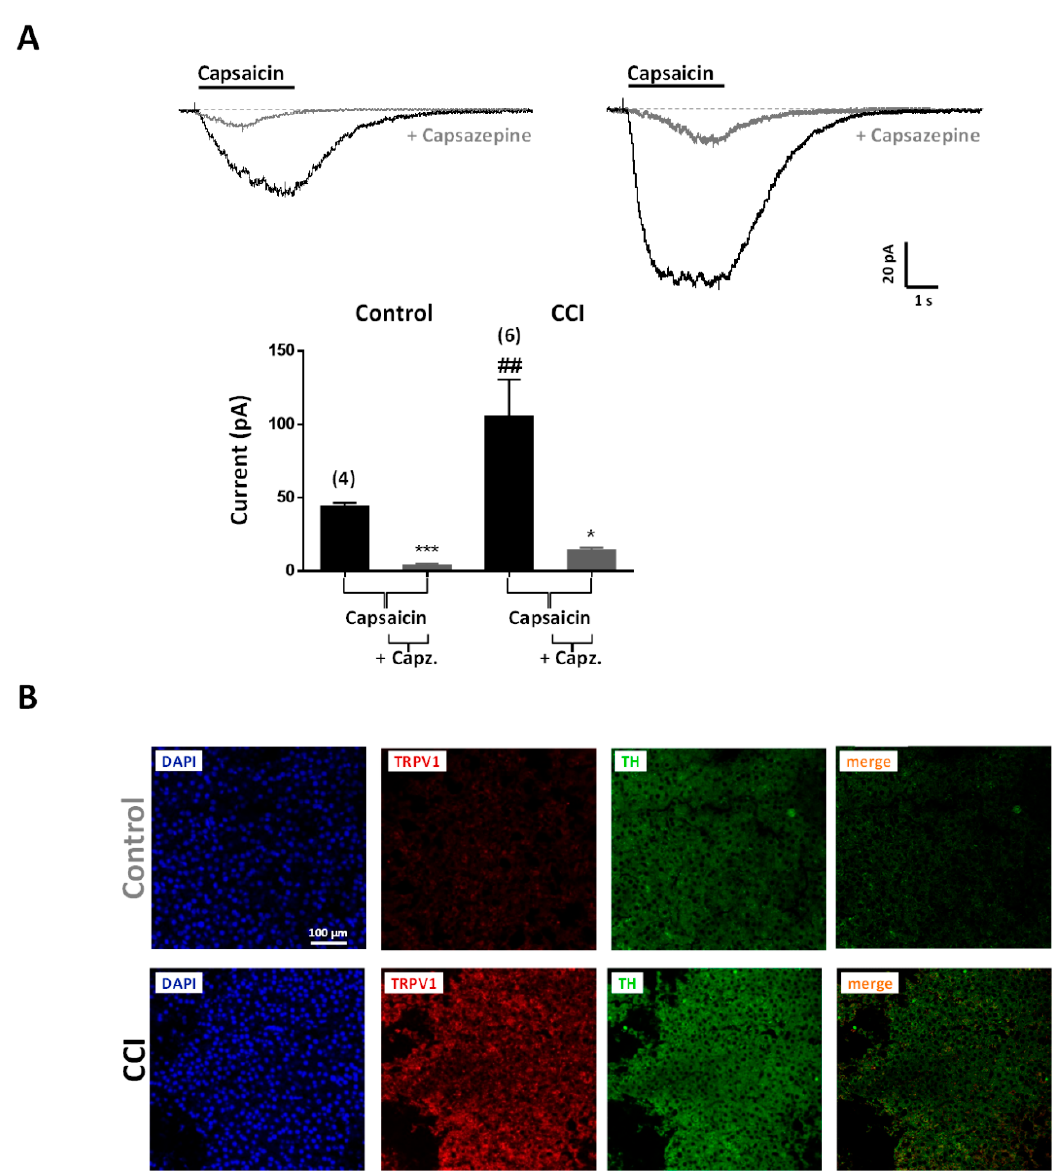
Figure 9. Plasticity of TRPV1 channels in chromaffin cells from CCI animals. ( A ) Voltage-clamp recordings of currents evoked by capsaicin in chromaffin cells of the adrenal gland from Control (left part) and CCI (right part) animals. The horizontal bars show the application of capsaicin (10 µM, 3 s), which was applied twice with a 10 min interval in the absence or the presence of capsazepine (+ Capsazepine; 10 µM, 2 min). Inset . Amplitudes of 10 µM capsaicin-evoked currents in chromaffin cells from Control and CCI animals in the absence and the presence of capsazepine (Capz.; 10 µM). Data are from the number of cells and animals shown between parentheses on top of bars. Statistical significances were assessed by a Student t test for paired data when evaluating the effect of capsazepine (*, p < 0.05; ***, p < 0.001), and unpaired data when evaluating the effect of CCI ( ## , <0.01). ( B ) Fluorescence confocal images of adrenal gland slices from Control (upper panels) and CCI animals (lower panels) stained for TRPV1 channels and tyrosine hydroxylase (TH). Cell nuclei were visualized following incubation with DAPI. Images are representative of those obtained from 3 Control and 3 CCI animals.